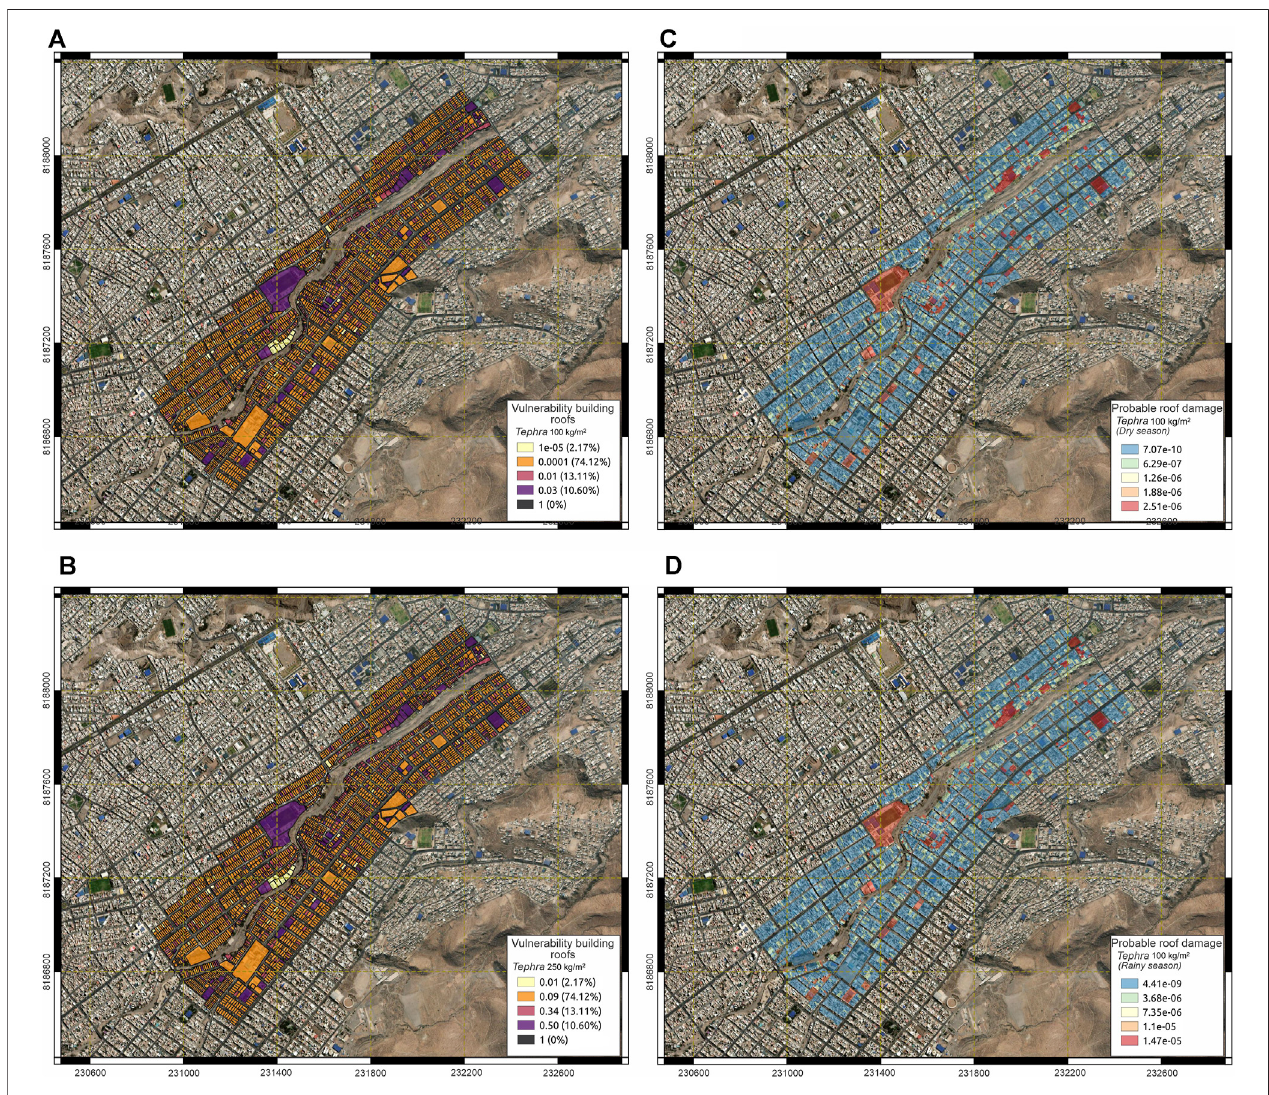
FIGURE3| Areal distribution and vulnerabilityindex ofroofclasses alongthemedial reachofQda.SanLazaro accordingto (A) Tephramassloadingof100 kg/m 2 and (B) Tephramassloadingof250 kg/m 2 .EvaluationofroofdamageprobabilitiesinthemedialreachofQda.SanLazarofor (C) Tephramassloadingof100 kg/m 2 and (D) Tephra mass loading of 250 kg/m 2